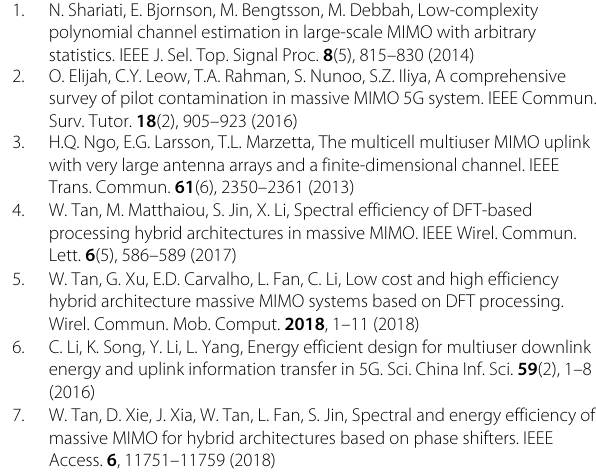
the 2D-SL0-SD data decoding method is proposed which can simultaneously decode a MPSK data block for mul- tiuser. Simulation results demonstrate that joint the 2D- SL0-CE with 2D-SL0-SD to estimate channel and decode MPSK data for multiuser massive MIMO is a feasible